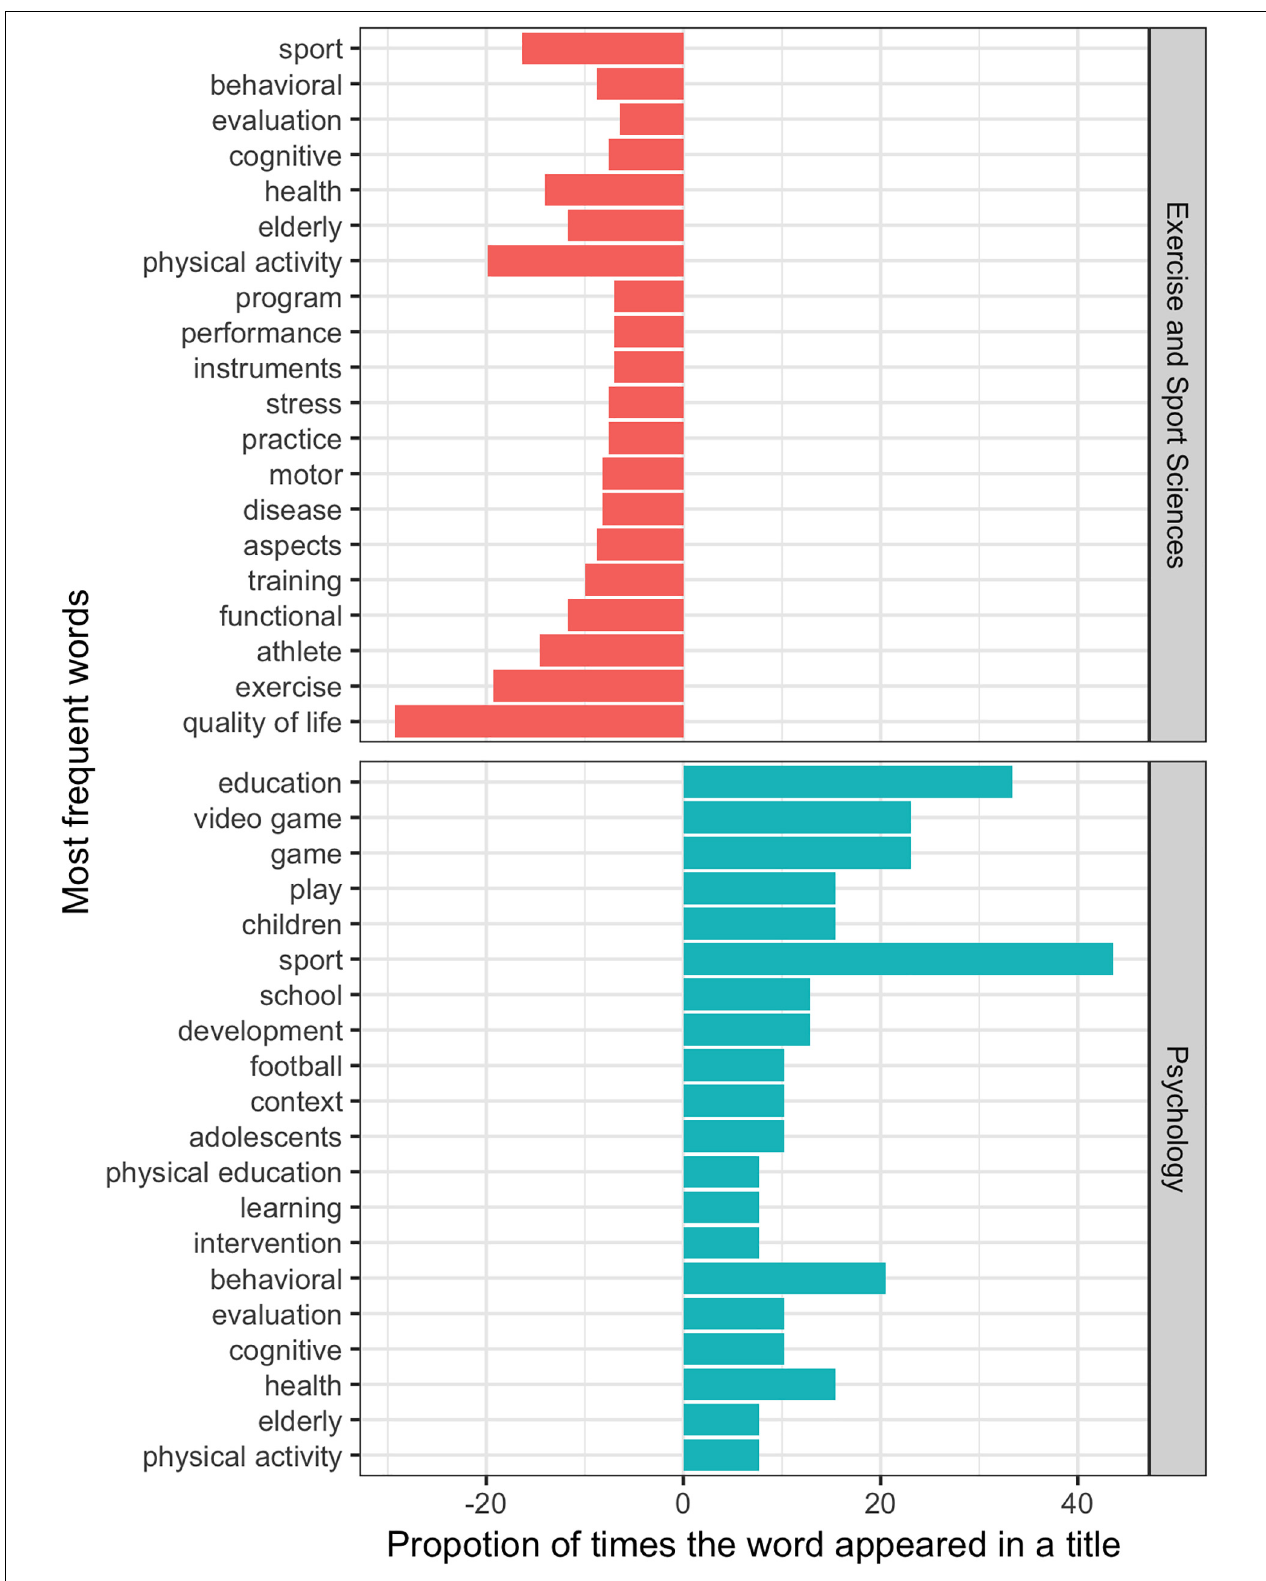
FIGURE 6 | Frequent words and the title word frequency in Exercise and Sport Science and Psychology GPs.